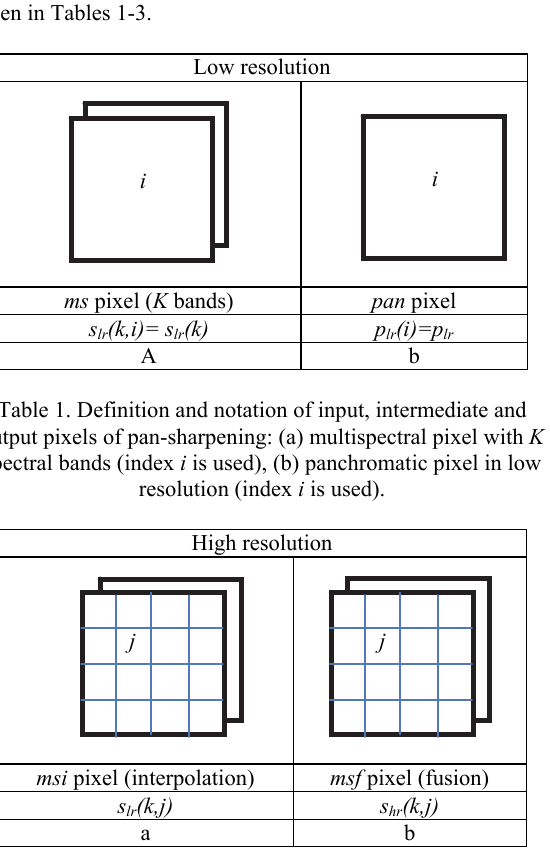
Table 2. Definition and notation of input, intermediate and output pixels of pan-sharpening: (a) interpolated multispectral pixel to the resolution of pan , (b) result of pan-sharpening (index j is used for high resolution pixels in the area occupied by ms pixel i